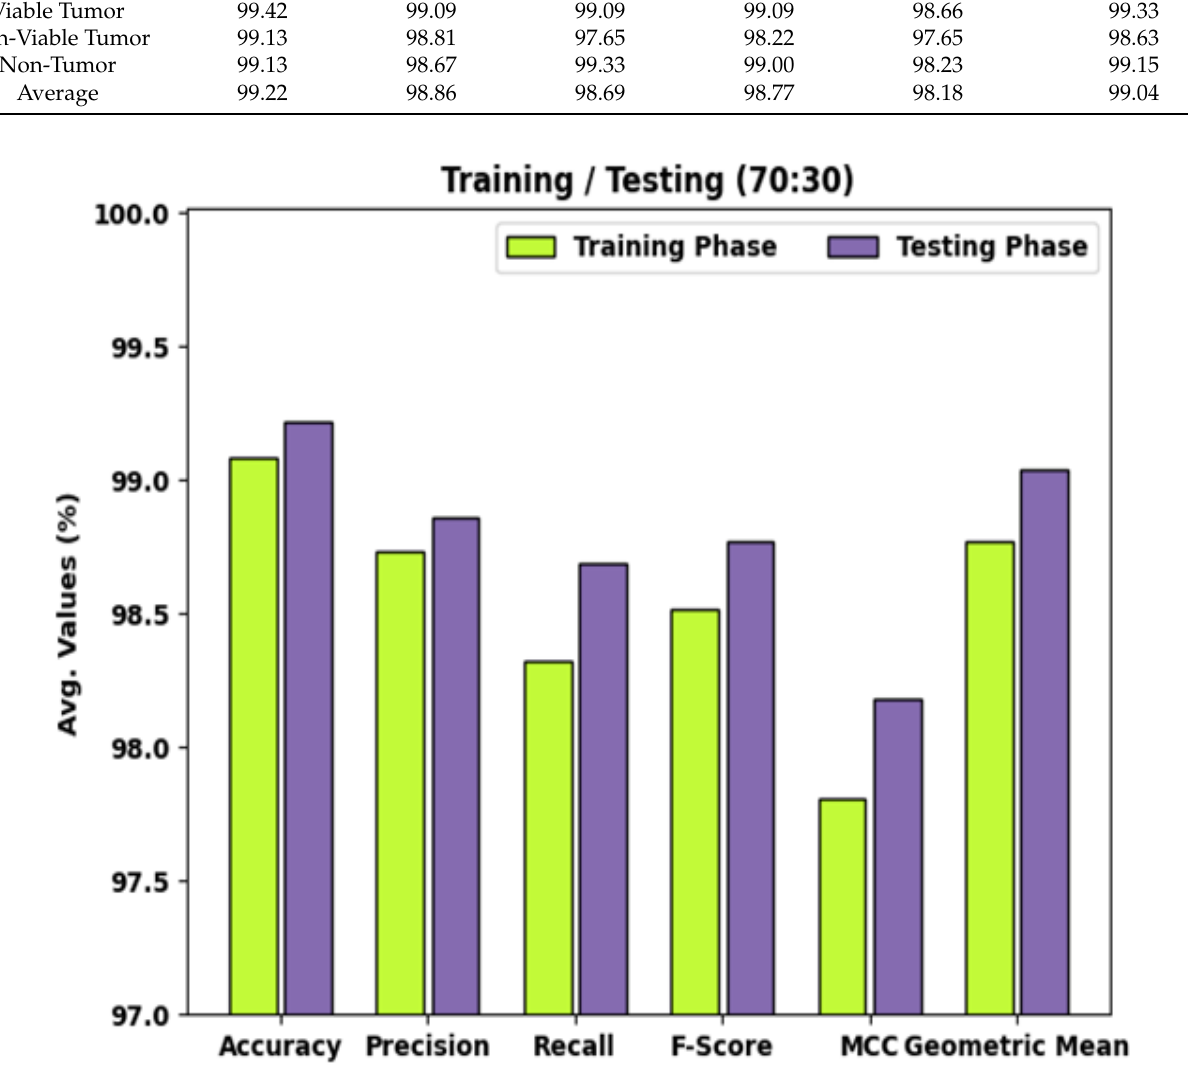
Figure 6. Result analysis of WDODTL-ODC technique under 70% of TR and 30% of TS data. For instance, the WDODTL-ODC system has identified samples under VT class with accu y , prec n , reca l , F score , MCC, and G mean of 99%, 98.30%, 98.30%, 98.30%, 97.59%, and 98.79% correspondingly. Besides, the WDODTL-ODC system has identified samples under NVT class with accu y , prec n , reca l , F score , MCC, and G mean of 99.25%, 99.43%,